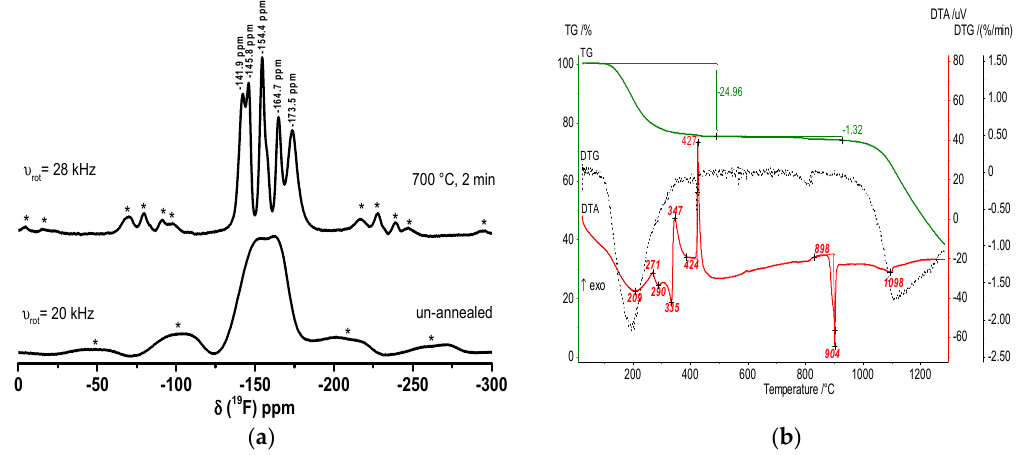
Figure 10. 19 F MAS spectra of un-annealed and annealed CaAl 2 F 8 xerogel at 700 ° C for two minutes ( a ) and TG/DTA heating curves ( b ). The spinning sidebands in the NMR spectrum are located under the * symbols.